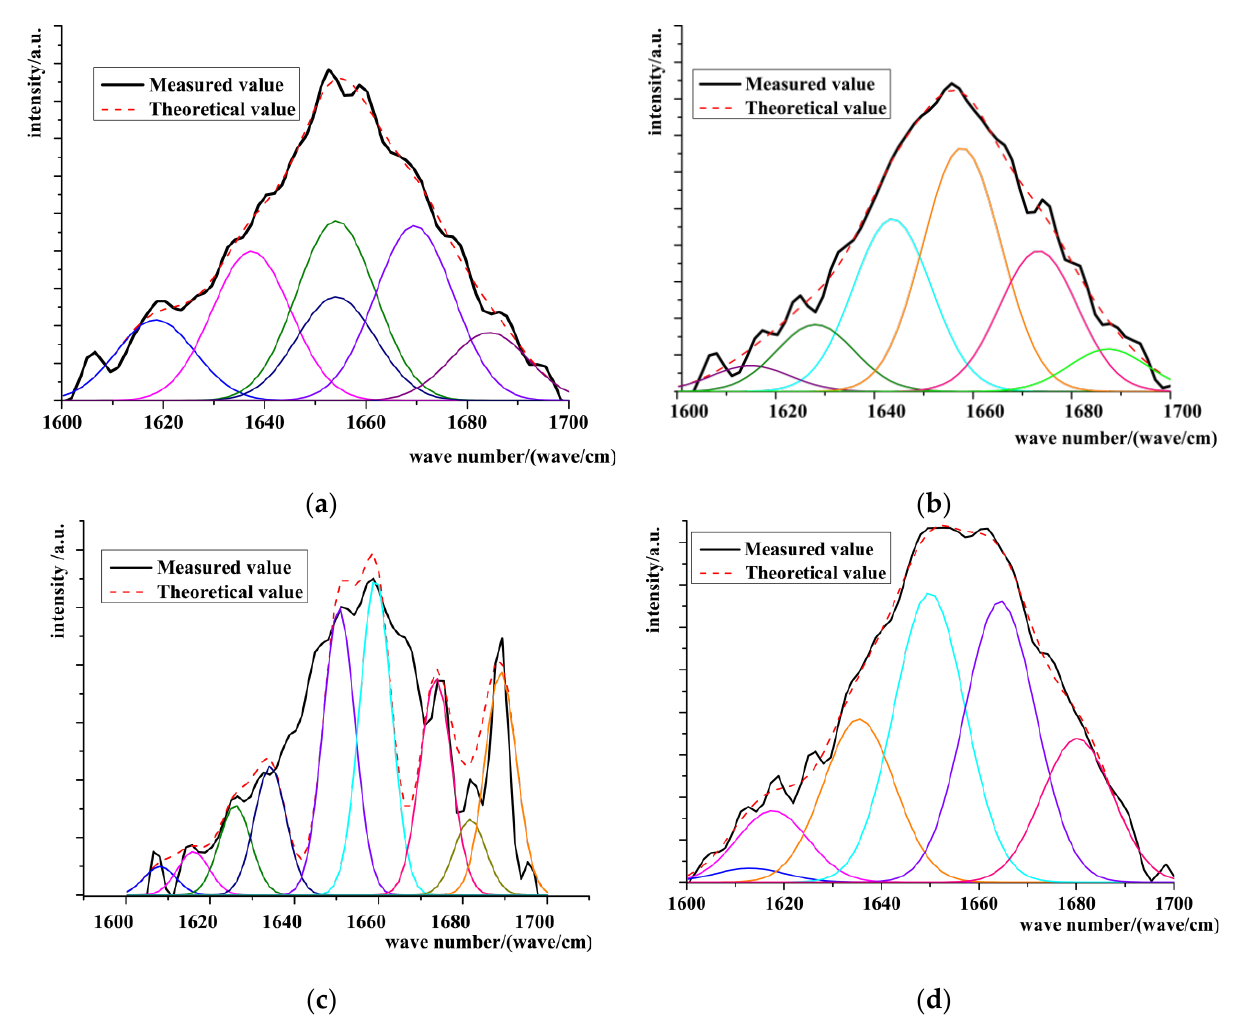
Figure 3. Protein amide I discrimination peak and iterative fitting curve of scallop interface adductor muscle under pressure. ( a ) Untreated; ( b ) 100 MPa; ( c ) 200 MPa; ( d ) 300 MPa.